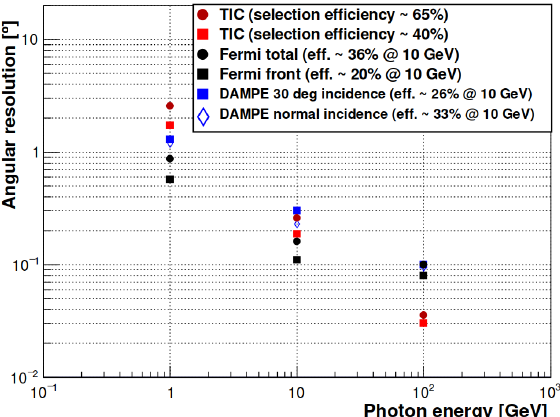
Figure 4. Angular resolution vs. Photon Energy: TIC compared to Fermi and DAMPE (from